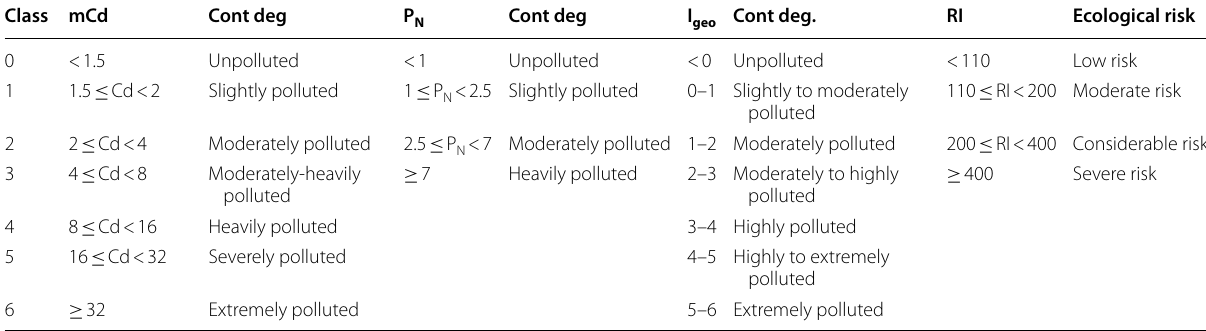
Table 1 Classification of heavy metal modified degree of contamination (mCd), nemerow pollution index (P of geo-accumulation (I ) and potential ecological risk geo Class mCd Cont deg P N Cont deg I geo Cont deg. RI Ecological